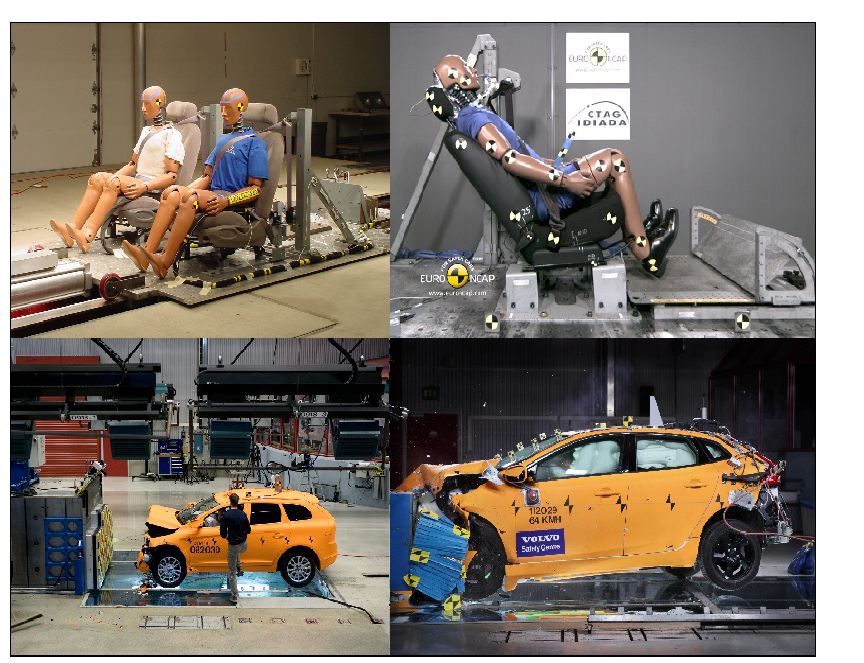
Figure 7 – Simulation of occupants in crash tests and tests of safety belts Рис . 7 – Моделирование поведения пассажиров в краш - тестах и при испытаниях